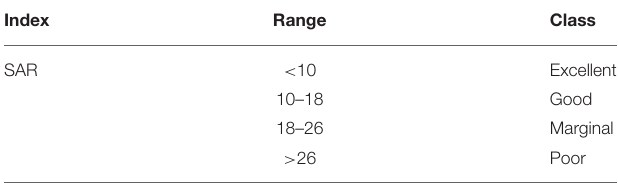
TABLE 3 | Classification of groundwater quality based on Na%.